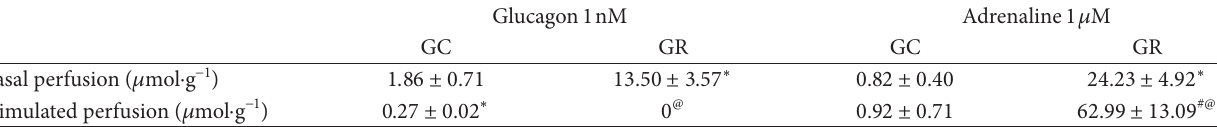
Figure 2: Blood glucose profiles of control and food-restricted rats during insulin-induced hypoglycaemia, either without exercise ((a), groups GC and GR) or after an acute exercise session ((b), groups GCex and GRex). Insulin was i.p. injected at time 0min and blood glucose was recorded for 300 min. Mean ± SD of 6–12 observations at each time. ∗ 𝑃 < 0.01 compared with time 0 min of the same group; # 𝑃 < 0.01 between groups at the same time, according to Student’s 𝑡 -test. Table 2: AUCs for the liver release of glucose in the fasted state.